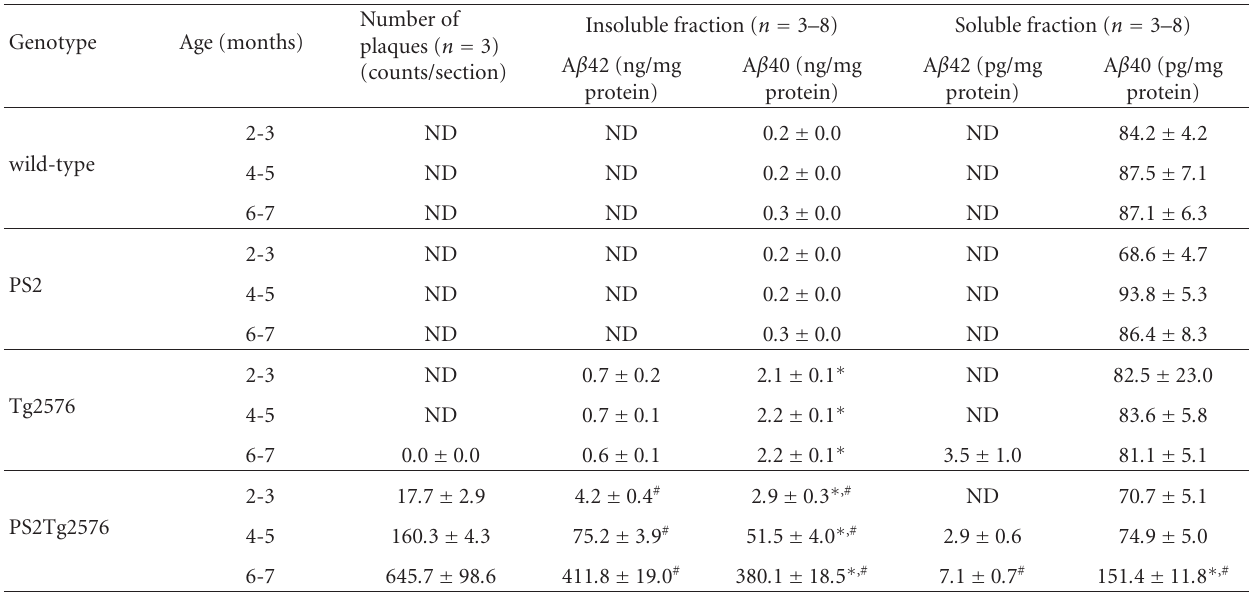
Table 1: Characterization of amyloid accumulation in the mouse